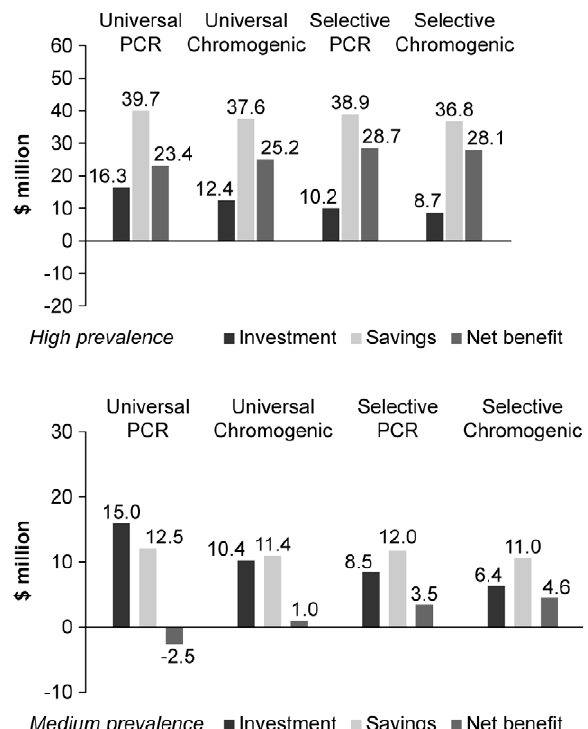
Figure 6. Total investment costs, savings and net benefit of strategies. Investment costs, savings (based on $ 17,645 averted hospital costs per averted infection ([6]) and net benefit in millions of US $ (2007), in high (left) and medium (right) prevalence settings.